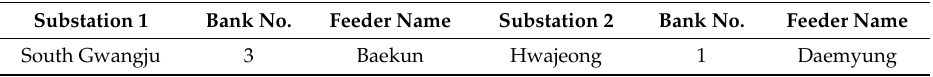
Table 3. Information of the switch between two substations.